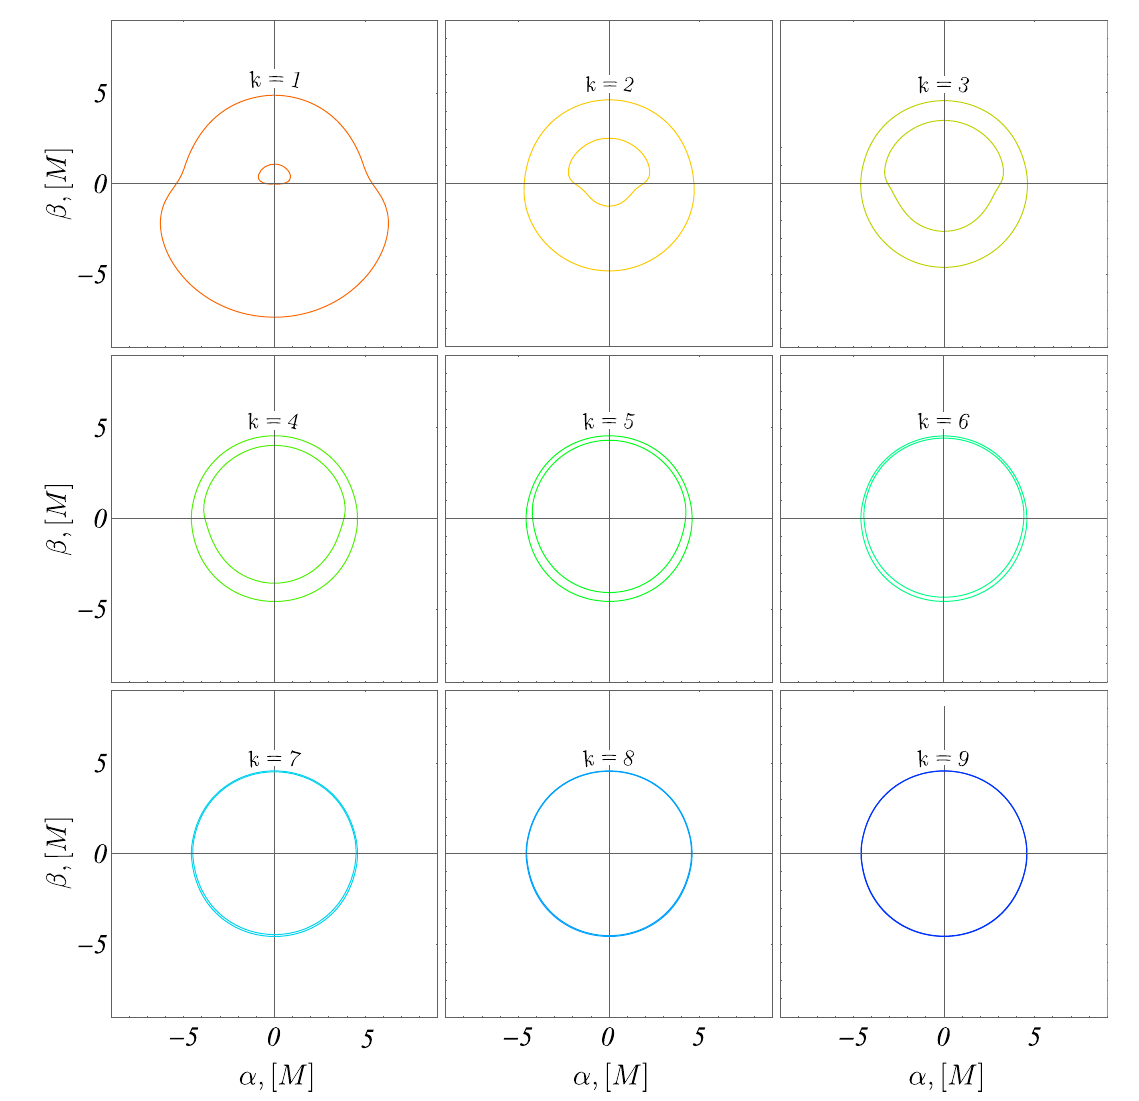
Fig. 6 Images of the circular orbit located at r = 10 M as seen by an observer at { r obs = 5000 M , i = 80 ◦ } . We illustrate the secondary images up to the order k = 9 r obs after making k / 2 loops around the coordinate